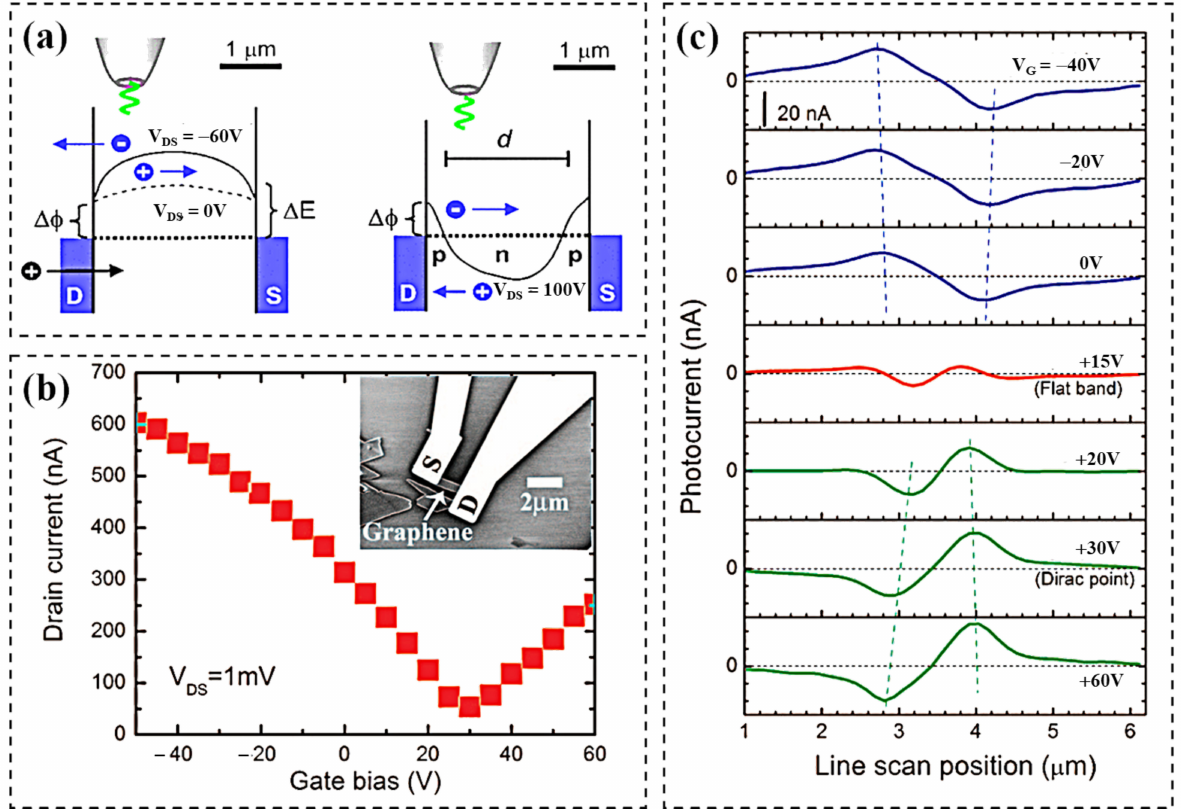
Figure 2. Photovoltaic Effect. ( a ) Band diagrams at VGS = 0 V ( dashed line ) and VGS = − 60 V ( solid line ) were obtained by numerical integration of the photocurrent profiles. ∆ φ describes the pinning of the Fermi level. Arrows indicate the flow of electrons and holes. ( b ) Electrical transport characteristic of a graphene transistor (drain current vs gate bias) at a drain bias of 1 mV. Inset: Scanning electron micrograph of the graphene transistor. ( c ) Photocurrent line scan profiles under different biases. ( a ) Reproduced with permission from [44]. Copyright American Physical Society, 2009. ( b ) and ( c ) reproduced with permission from [45]. Copyright 2009 American Chemical Society,